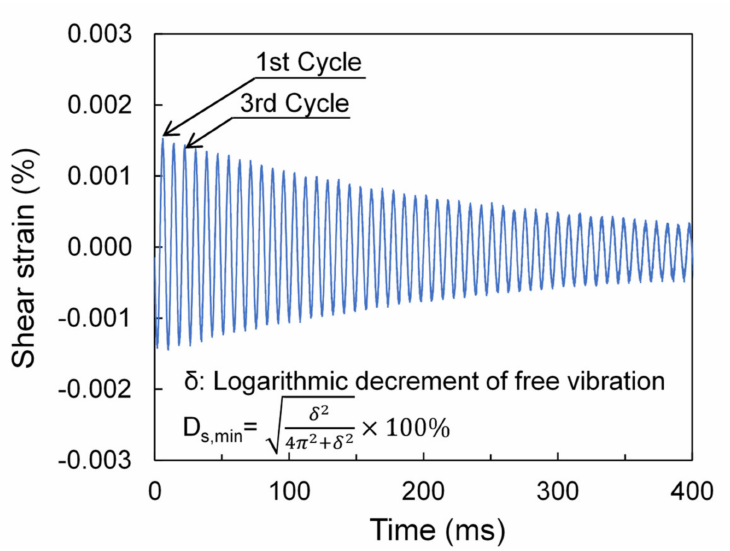
Figure 5. Typical test results and small-strain damping ratio calculations based on the free vibration decay method for pure SS sample at 200